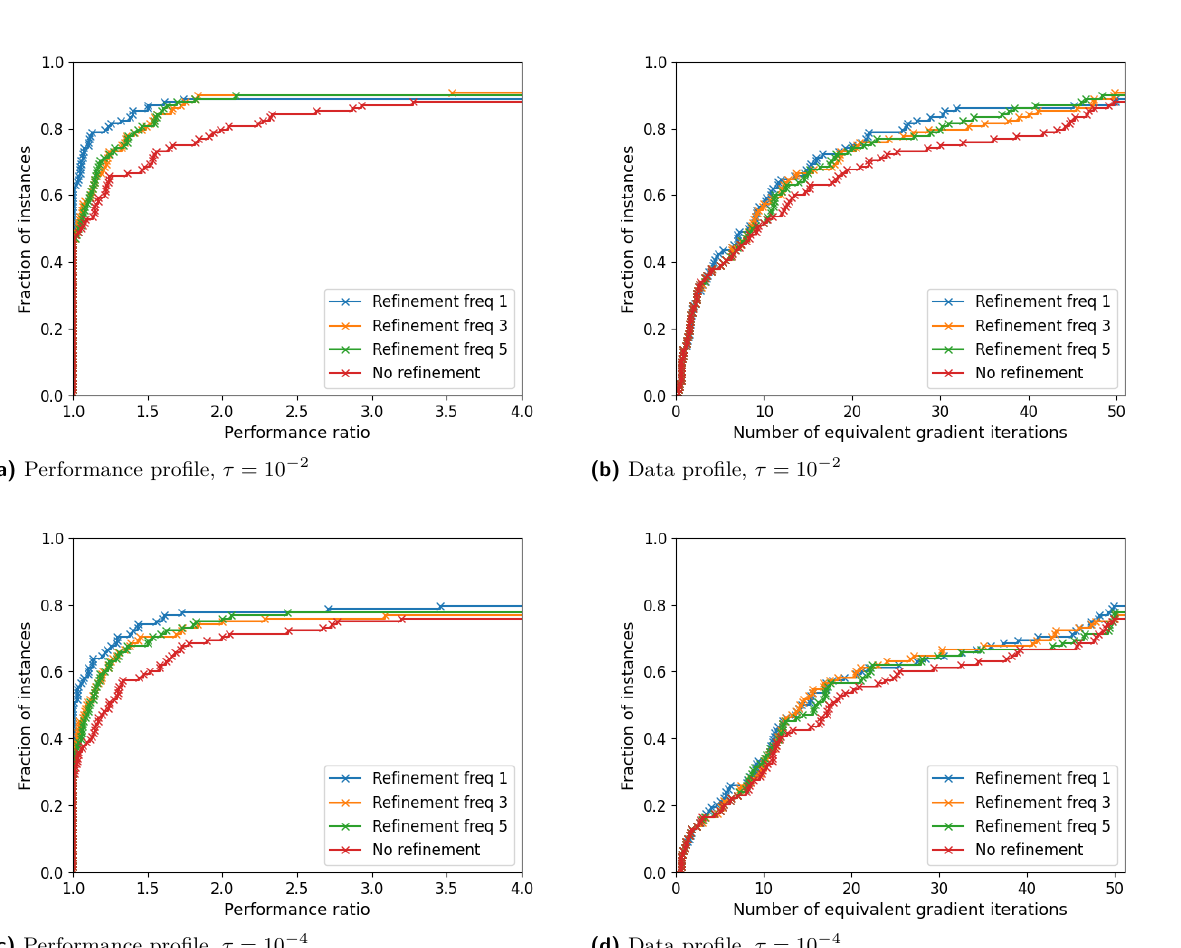
Figure 3 Performance profiles (left) and data profiles (right) with and without the Refinement step. The “Frequency” of the Refinement step indicates after how many Iteration steps it is performed.